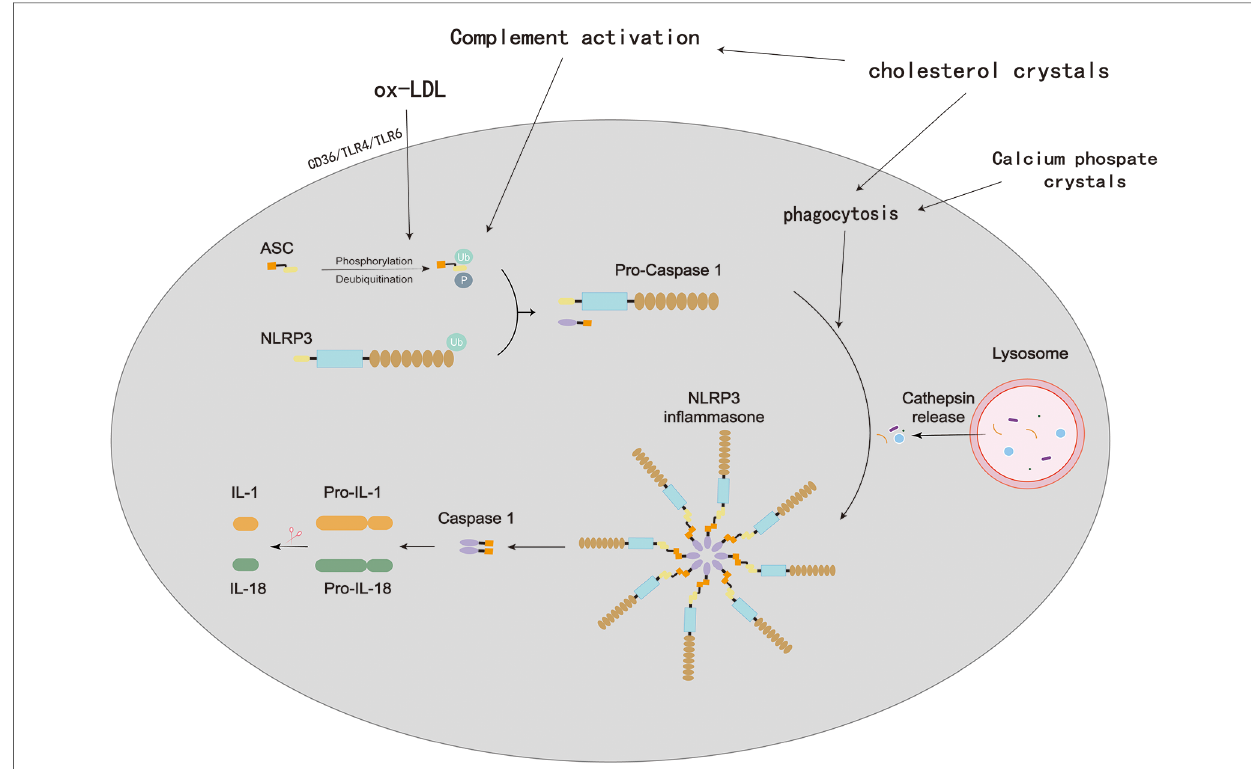
FIGURE 8 Process of NLRP3 in fl ammasome activation in atherosclerosis. In atherosclerotic lesions, oxidized low-density lipoprotein (oxLDL) and cholesterol crystals (CCs) are prevalent and promote a self-sustaining cycle of continuous NLRP3 in fl ammasome priming and activation in macrophages. OxLDL binds to CD (cluster of differentiation)36, which triggers oxLDL phagocytosis and a priming signal via TLR (Toll-like receptor)4/TLR6. Lysosomal damage brought on by the phagocytosis of extracellular CCs results in the activation of the NLRP3 in fl ammasome. Additionally, CCs stimulate the complement system, which encourages CC phagocytosis and consequently, NLRP3